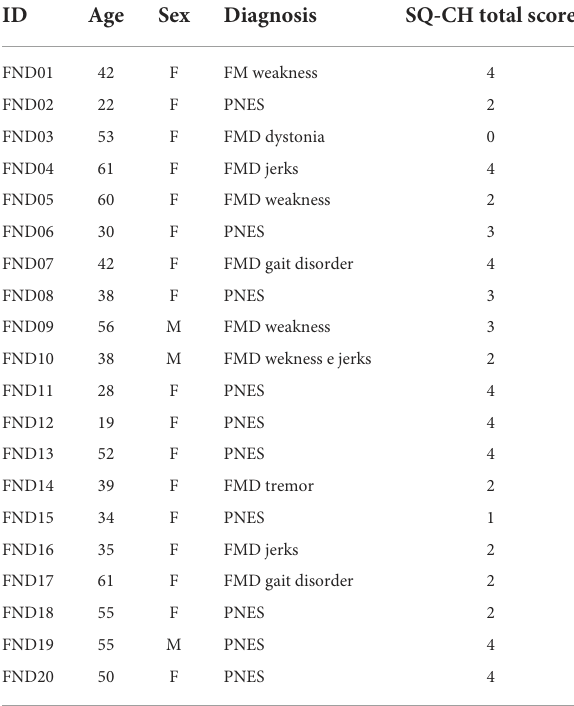
TABLE1 Demographic andclinical informationfor patients